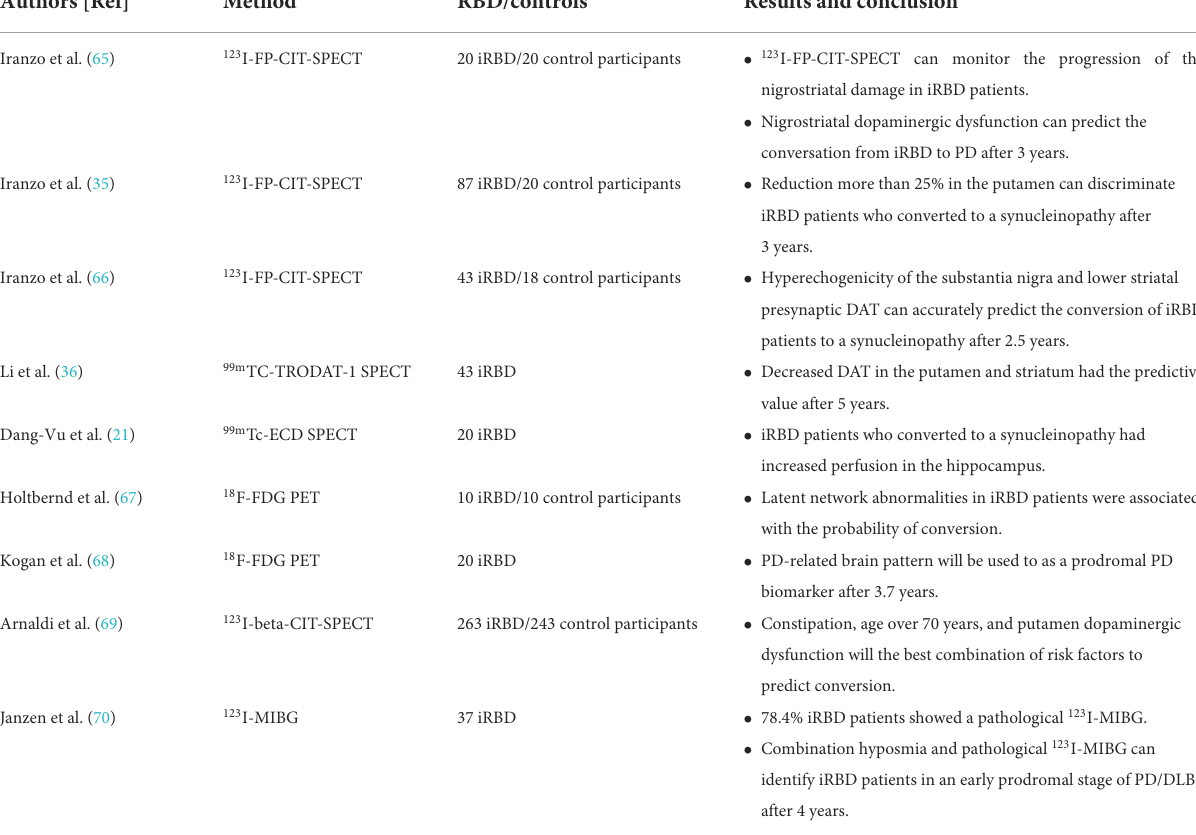
TABLE 1 Main findings of each neuromolecular imaging studies in iRBD